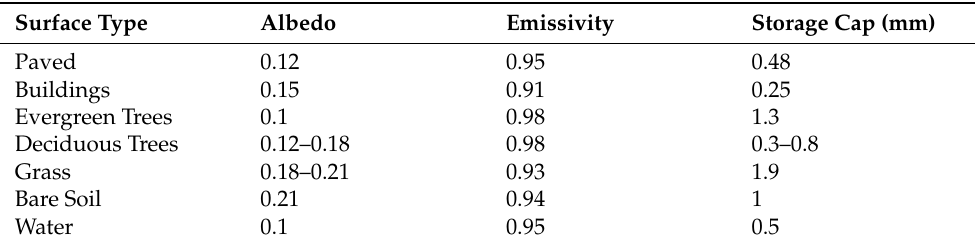
Table 1. Parameterization of surface cover classes, same as Panagiotakis et al. (2021) [16], Ward et al. (2016) [34].